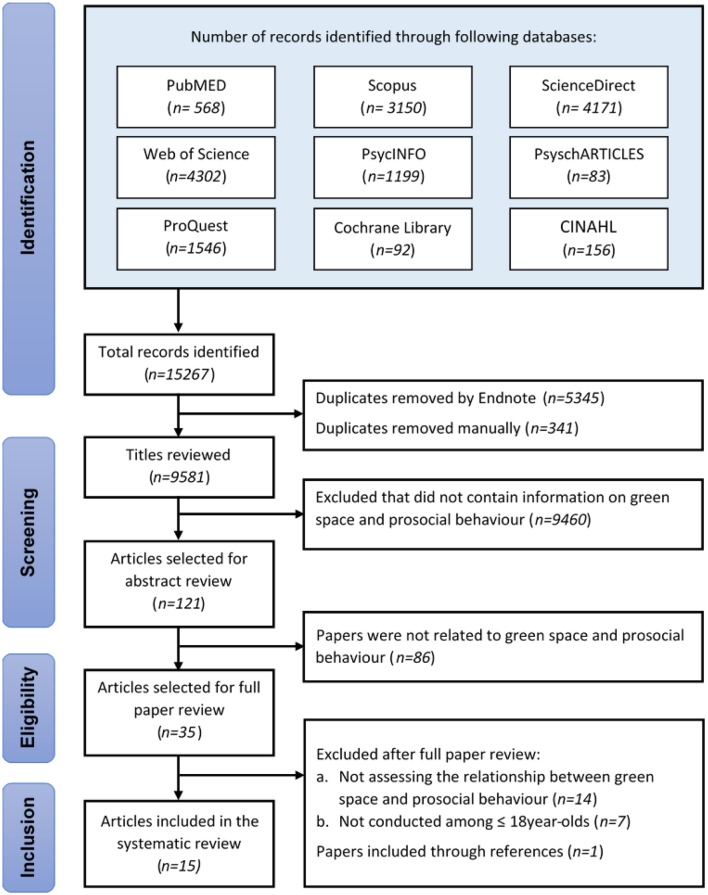
Study selection process based on PRISMA guidelines.